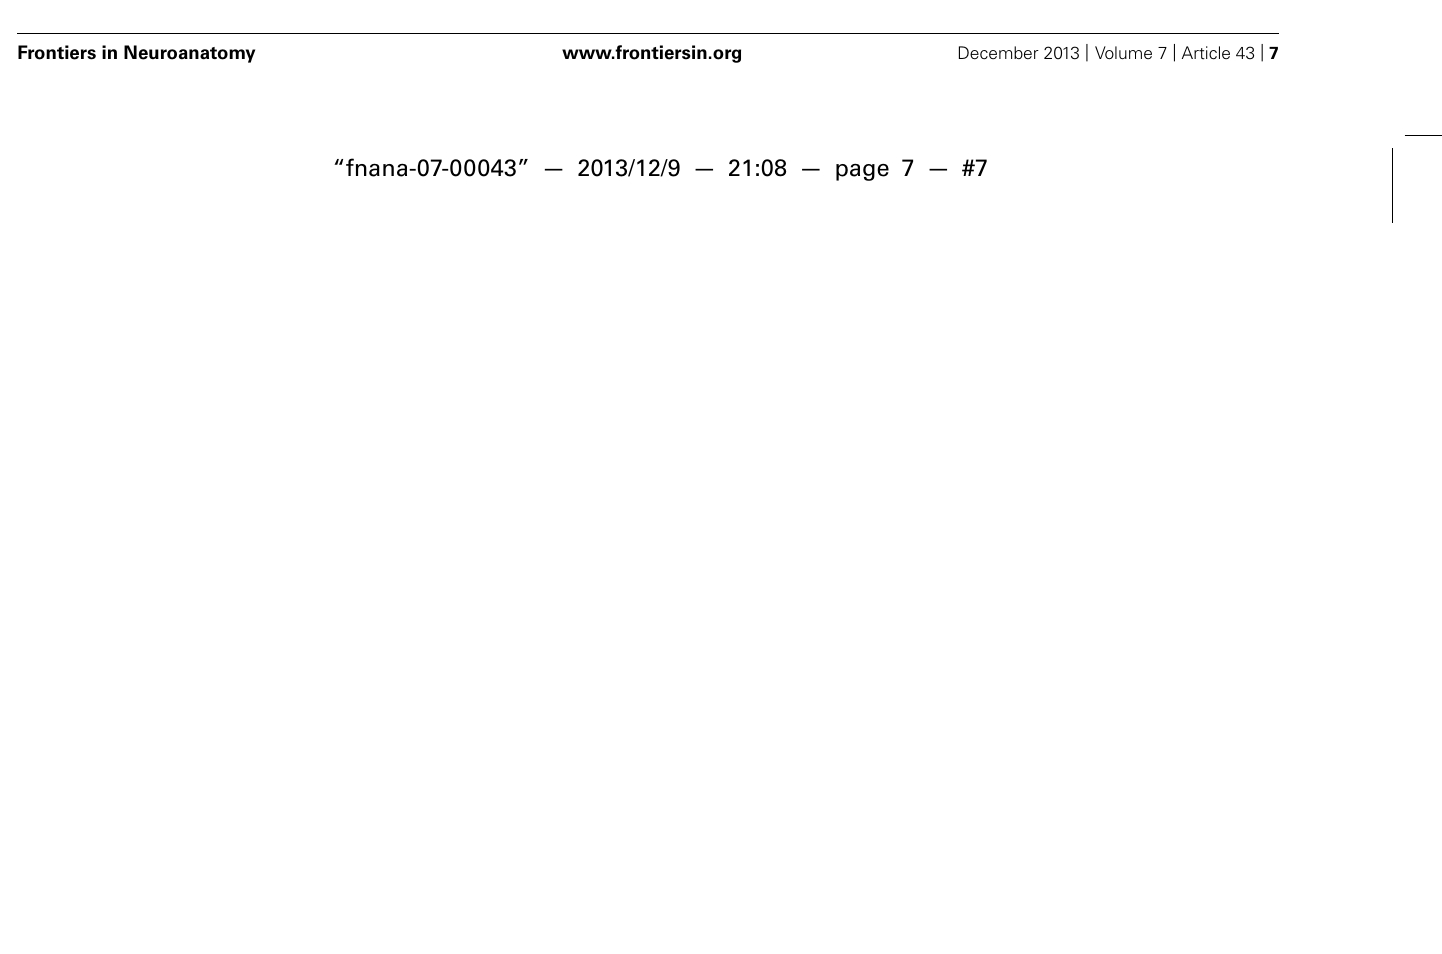
( Figure 4C2 ). At the level of the caudal optic chiasm, hrGFP- IR axons formed a number of fascicles in the ventral portion of the VP, which spread ventrally into the dorsal portion of the SI ( Figure 4C3 ). Within the SI, wavy hrGFP-IR axons appeared withsmallroundvaricosities(794boutons/varicosities),sentsome terminals to the SI ( Figure 5F ), and further extended